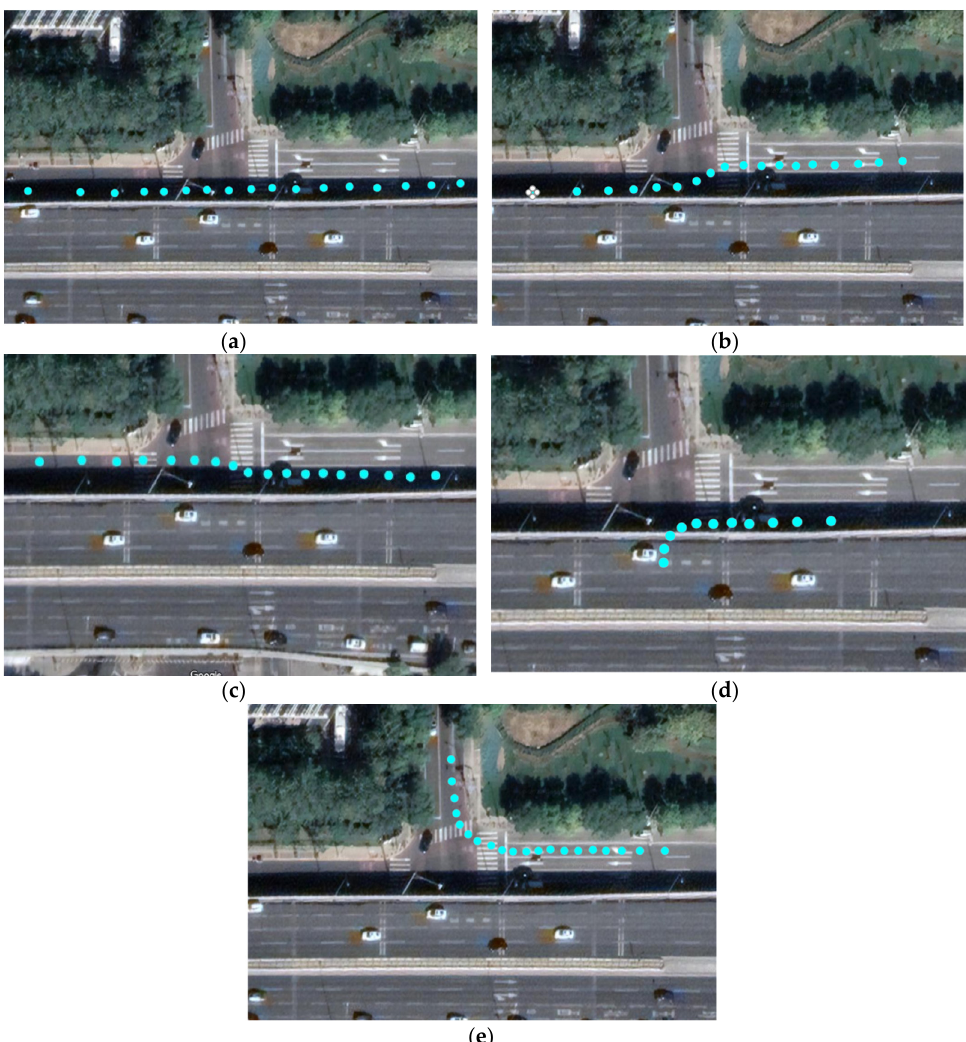
Figure 7. Driving behaviors and trajectories of ICVs at the intersection. ( a ) straight ahead; ( b ) left lane change; ( c ) right lane change; ( d ) left turn; ( e ) right turn.